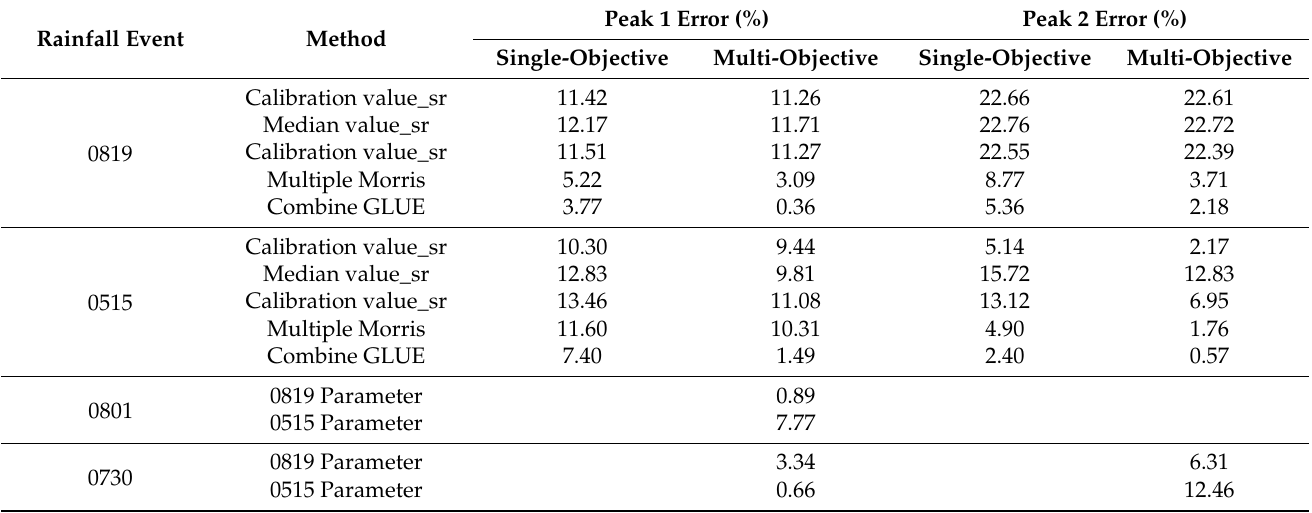
Table 6. Peak flow relative error of model simulations during the calibration and validation